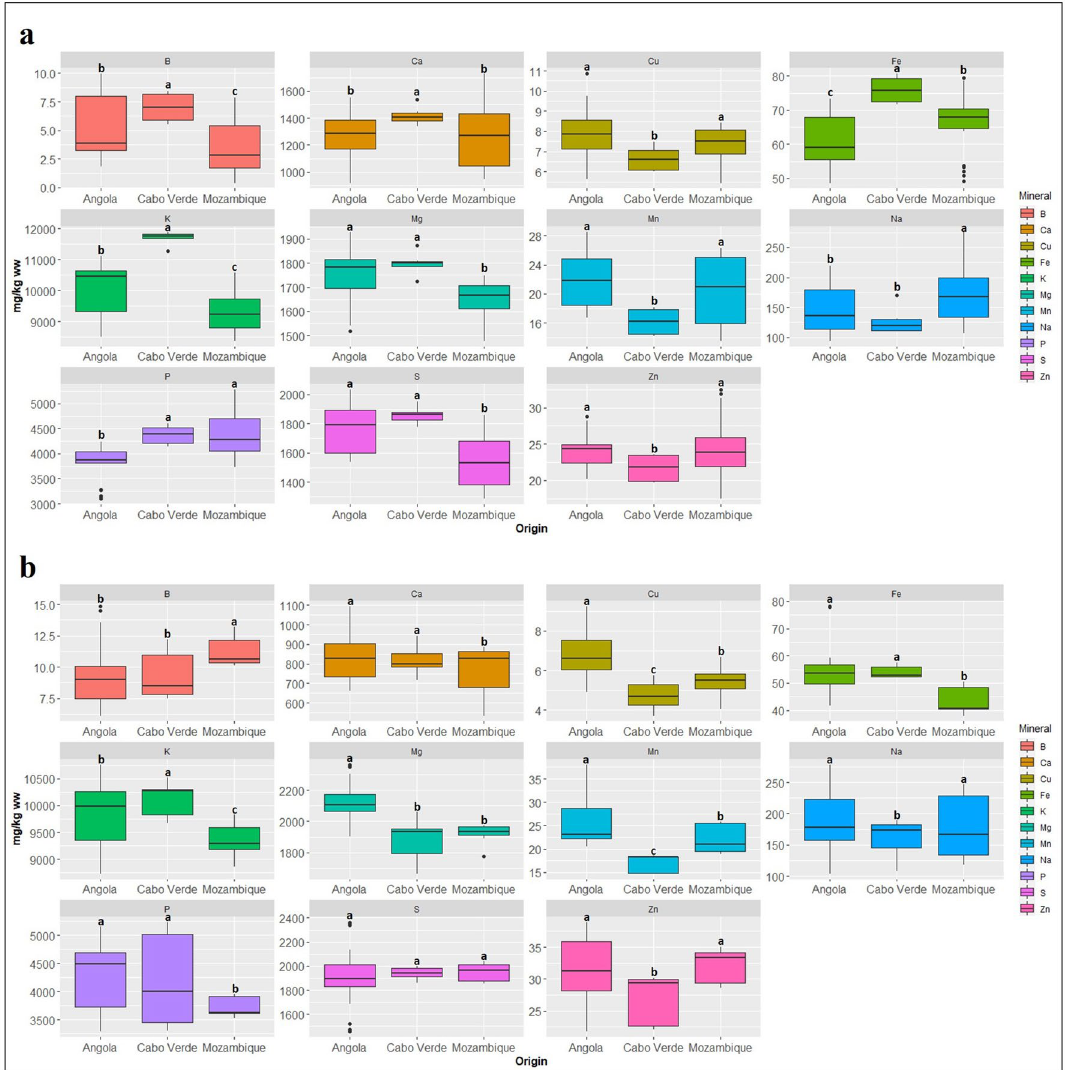
Figure 5. Variation of mineral content (mg/kg ww) and the geographical origin for the studied samples: ( a ) Phaseolus vulgaris (21 accessions), and ( b ) Vigna unguiculata (17 accessions). Geographical origins sharing the same letter are not statistically different according to the Scott-Knott test at 5% of